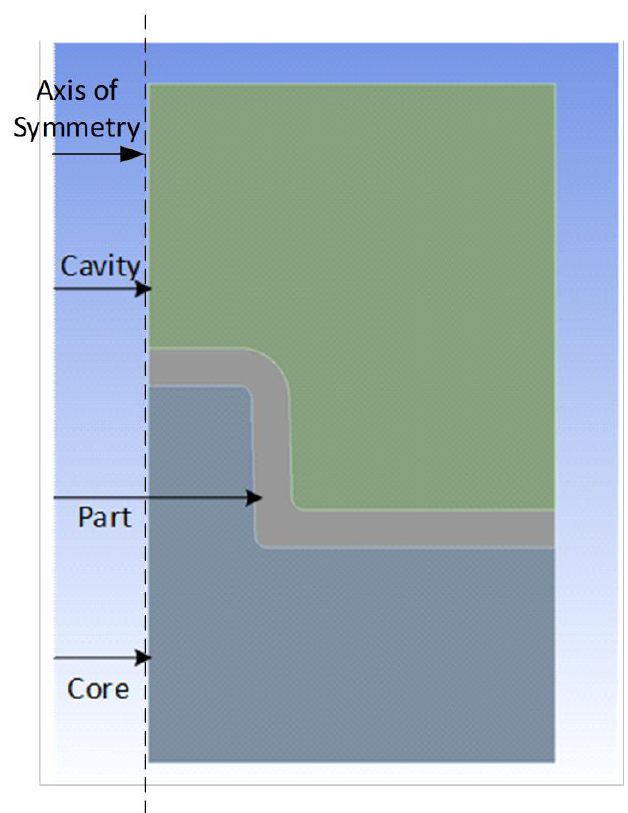
Figure 9. 2D Axisymmetric model of the core, cavity and part